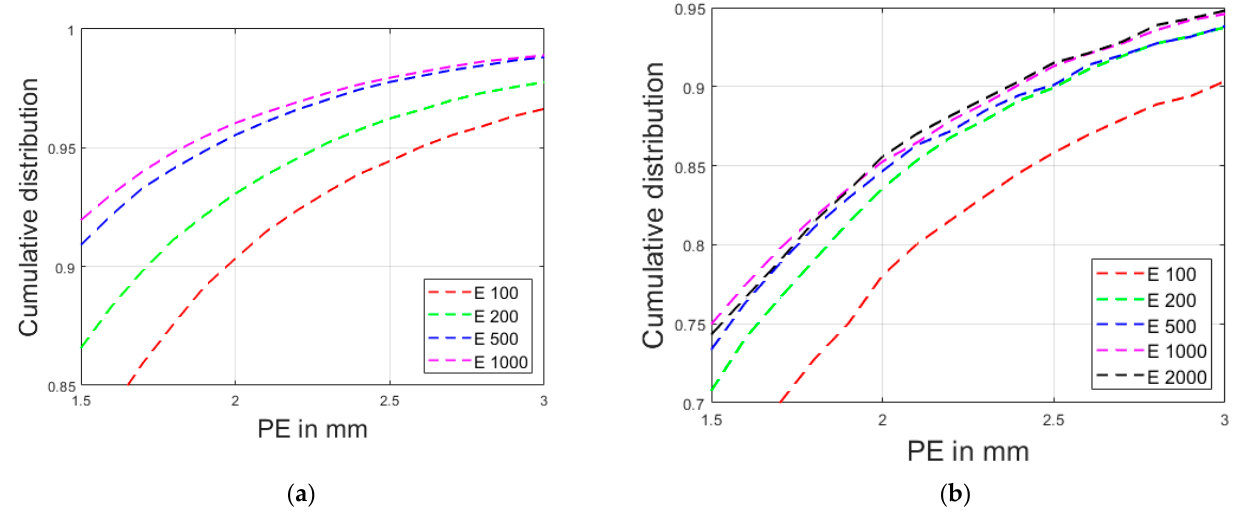
Figure 5. MRE curves according to different epochs. ( a ) Digital Hand Atlas dataset (Hybrid with U-Net). ( b ) ISBI 2015 test1 dataset (Edge Detection with U-Net).